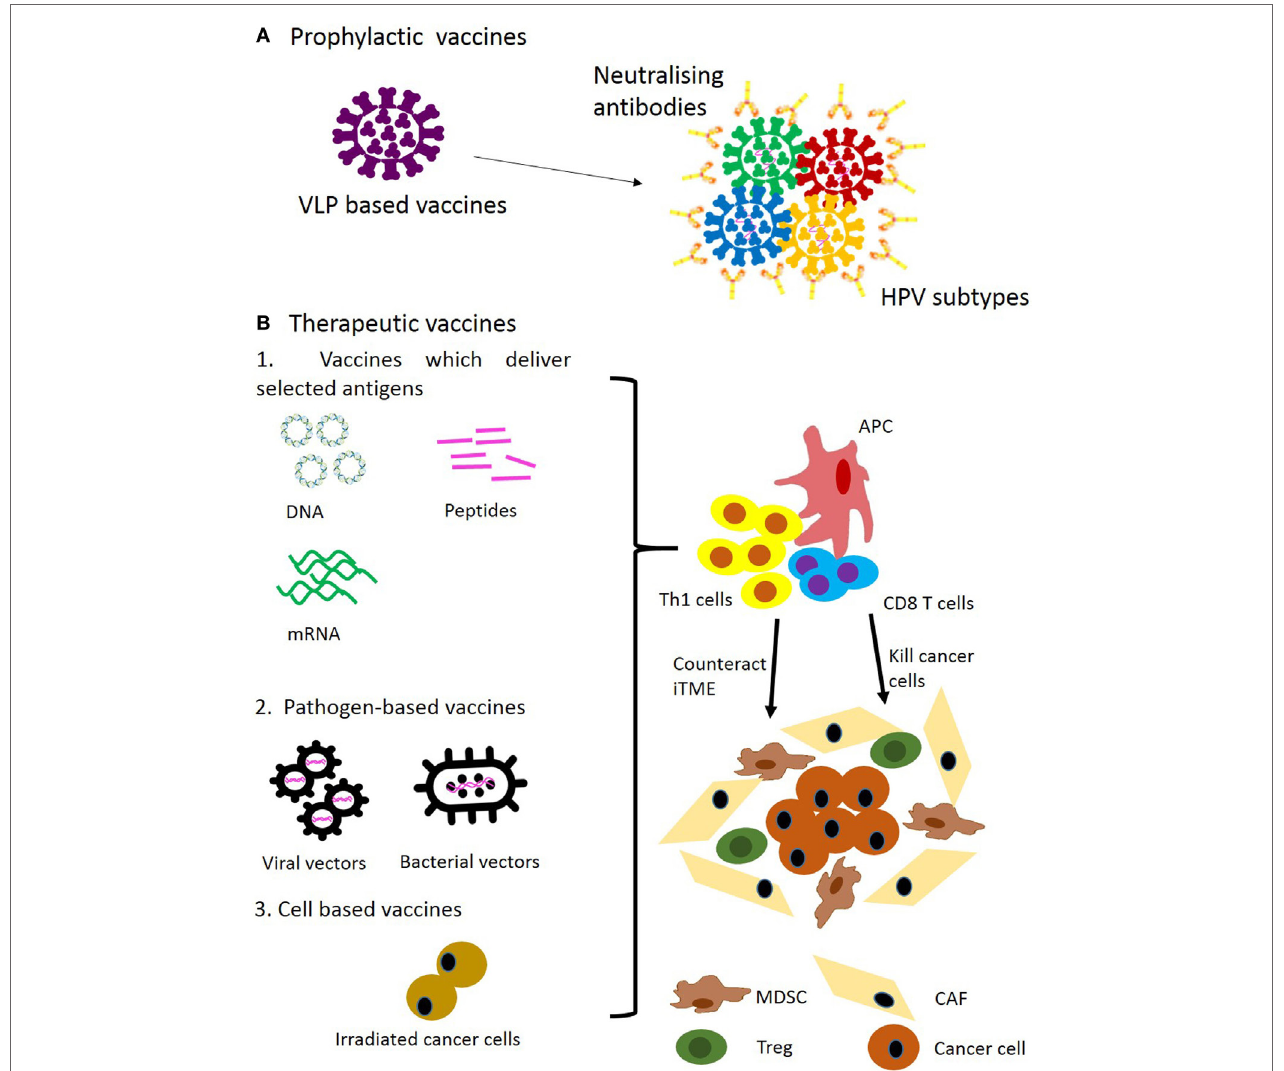
FiGURe 1 | Approaches for prophylactic (A) and therapeutic (B) vaccination for head and neck cancer. Abbreviations: VLP, virus-like particle; iTME, immunosuppressive tumour microenvironment; MDSC, myeloid-derived suppressor cell; Treg, regulatory T cell; CAF, cancer-associated